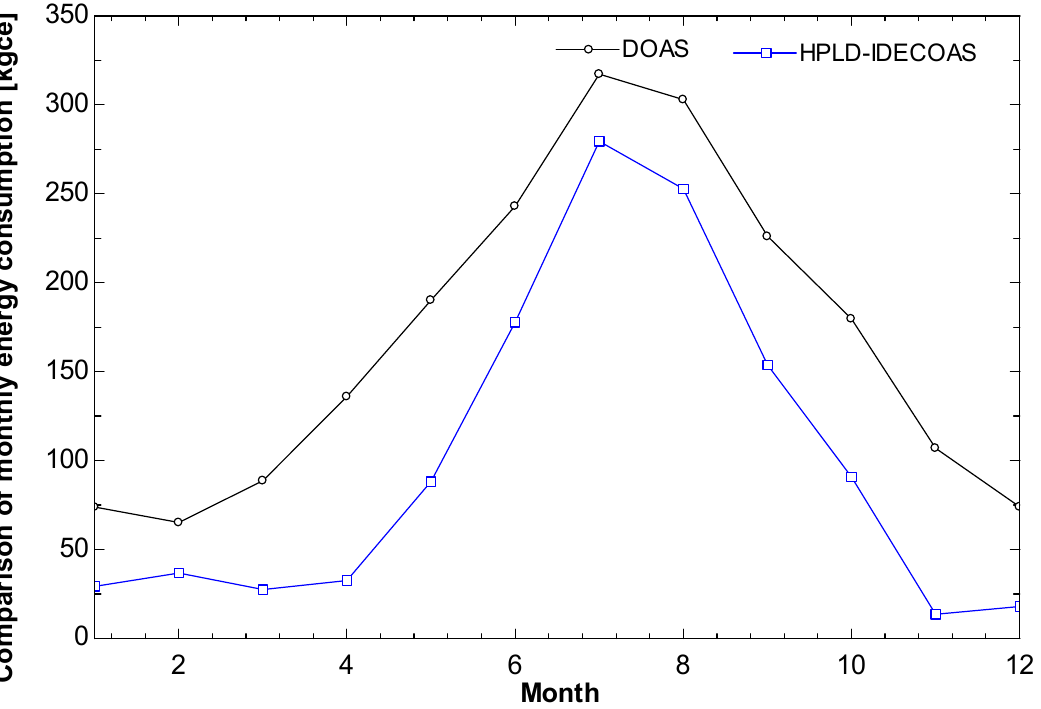
Figure 13. Comparison of monthly energy consumption in Guangzhou.